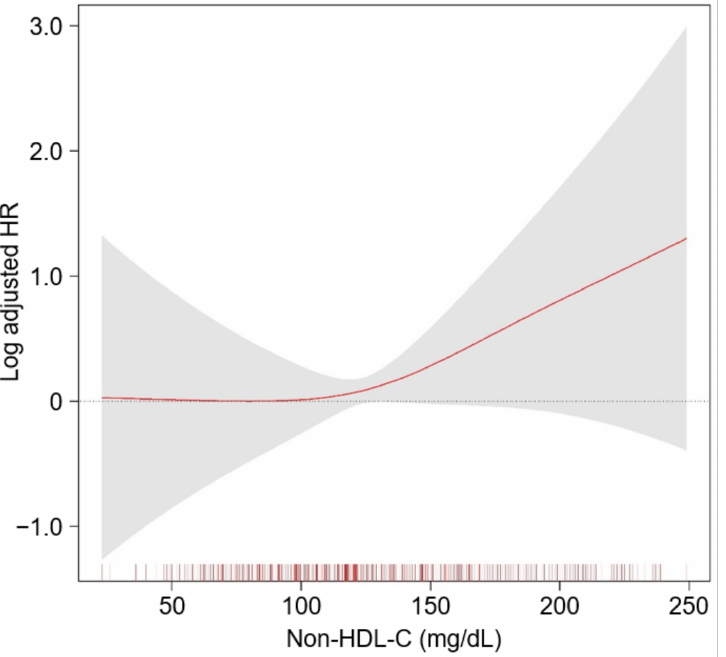
Figure 3. Restricted cubic spline of non-HDL-C on a composite CV event. The adjusted HR of non-HDL-C as a continuous variable for composite CV event is depicted. The model was adjusted for age and sex, Charlson comorbidity index, primary renal disease, current smoking status, medication (ACEIs/ARBs, diuretics, number of anti-HTN drugs, statins), BMI, SBP, DBP, hemoglobin, albumin, LDL-C, TG, fasting glucose, 25(OH) vitamin D, hs-CRP, eGFR, spot urine ACR, LVMI, and LVEF. Abbreviations: CI, confidence interval; HDL-C, high-density lipoprotein cholesterol; HR, hazard ratio; ACEIs, angiotensin converting enzyme inhibitors; ARBs, angiotensin receptor blocker; HTN, hypertension; BMI, body mass index; SBP, systolic blood pressure; DBP, diastolic blood pressure; LDL-C, low density lipoprotein cholesterol; TG, triglyceride; hs-CRP, high-sensitivity C-reactive protein; eGFR, estimated glomerular filtration rate; ACR, albumin-to-creatinine ratio; LVMI, left ventricular mass index; LVEF, left ventricular ejection